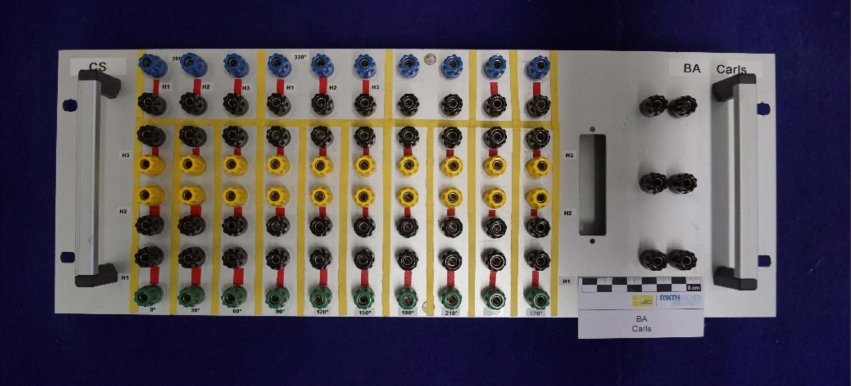
Figure 1. Breadboard for the connection of the LCR meter and different electrodes.